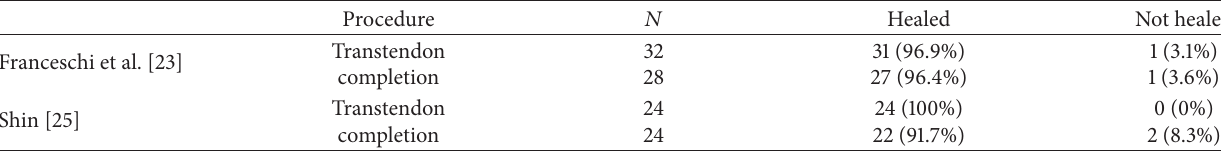
Table 6: Tendon healing on MRI.